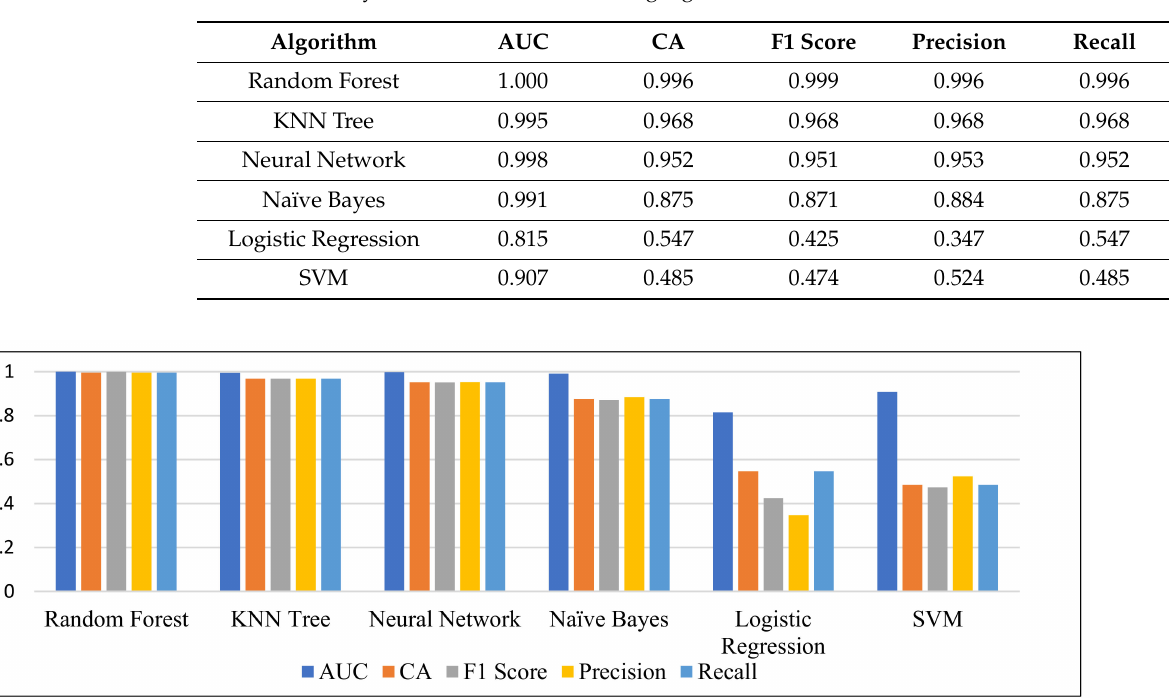
Table 7. Accuracy result and machine learning algorithm.